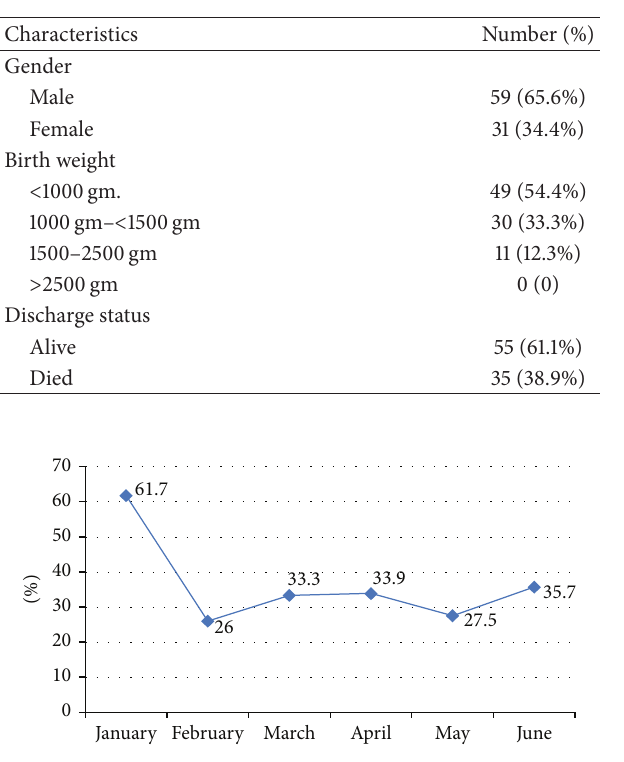
Table 2: Characteristics of the infected neonates ( 𝑛 = 90) within 6- month period.